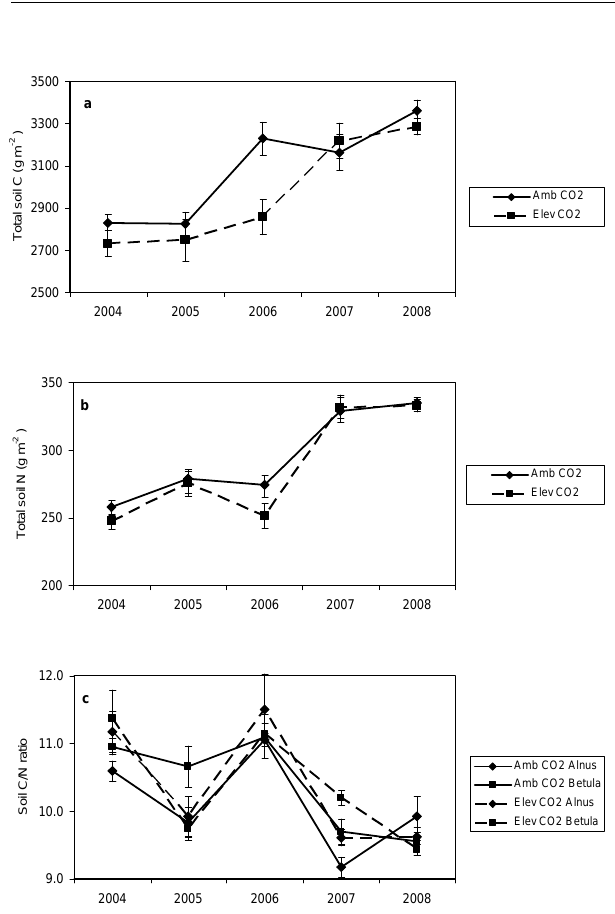
Fig. 1. Change of total soil C (a) and N (b) and soil C/N ratios (c) at 0–10cm